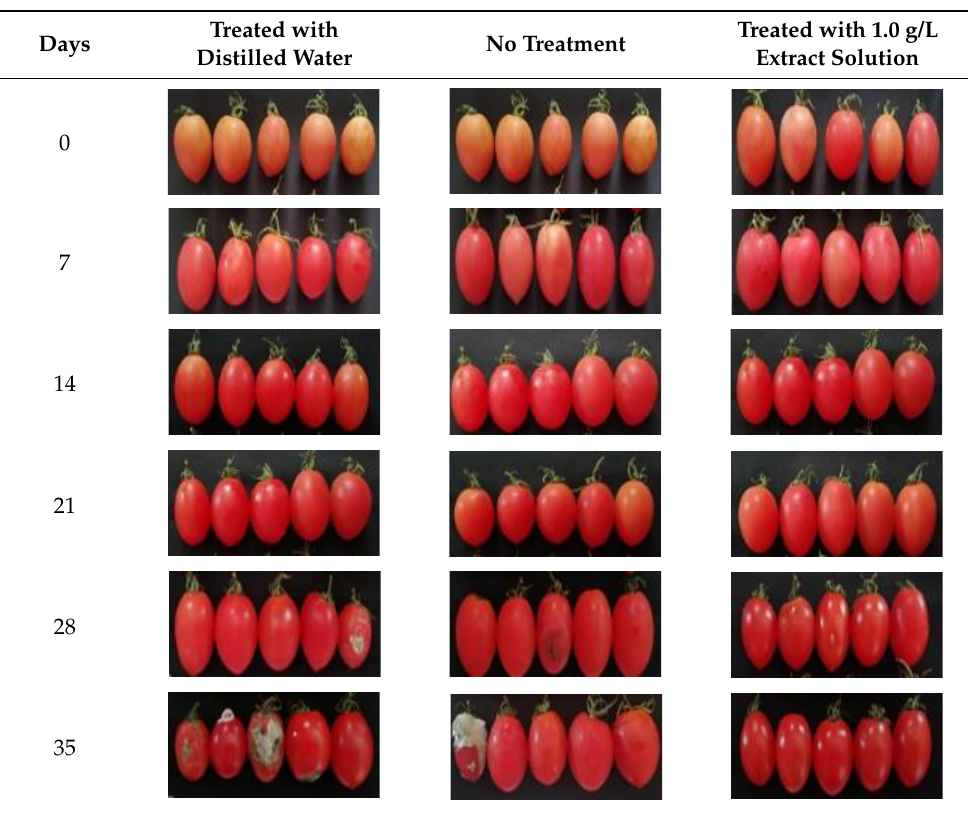
The effect of different concentrations of Lycium barbarum leaf extract on the vitamin C content of cherry tomato fruits at different ambient temperatures was significantly dif- ferent ( p < 0.05). Figure 7 shows that the vitamin C content of cherry tomatoes increased and then decreased during storage, and treatment with Lycium barbarum leaf extract in- hibited the reduction in vitamin C content to varying degrees. The cherry tomatoes were not fully mature, and they underwent a post-ripening process in the early stage of storage, which is why the vitamin C content initially increased. Thus, a peak in the vitamin C con- tent of the tomatoes occurred before a downward trend (Figure 7A), as was also shown by Liu et al. [16]. The first peak in vitamin C content of 32.09 mg/g occurred after storage for seven days and the second peak of 35.95 mg/g was found after treatment with Lycium barbarum leaf extract at 0.4 g/L after storage for nine days. The different Lycium barbarum leaf extract concentrations had different effects on delaying the loss of vitamin C from tomatoes, and 0.4 g/L was the most effective. After storage for up to 21 days, the vitamin C content of tomatoes was lower under treatment with Lycium barbarum leaf extract at 0.8 g/L and 1.0 g/L compared with CK (Figure 7B). Thus, high concentrations of Lycium bar- barum leaf extract were not effective at maintaining the vitamin C content of tomatoes.